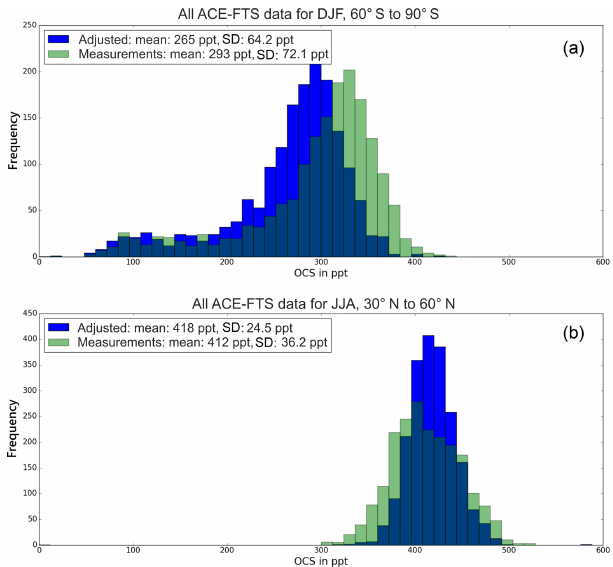
Figure 3. Comparison of the distributions and resulting mean and standard deviation values of measured (green) OCS and the adjusted measurements using Eq. (2) (blue) for the same time–latitude bins indicated by the black (a) and red (b) boxes in Fig. 1. Histograms include all 12 years of ACE-FTS OCS mixing ratio measurements at 16km